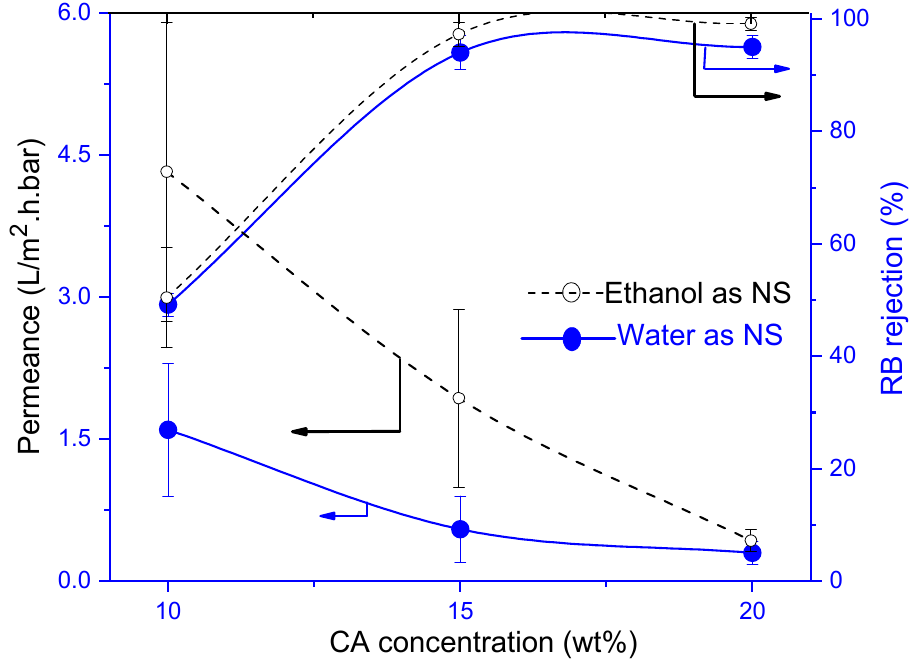
Figure 3. Influence of increasing polymer concentration on rheology of the casting solutions.